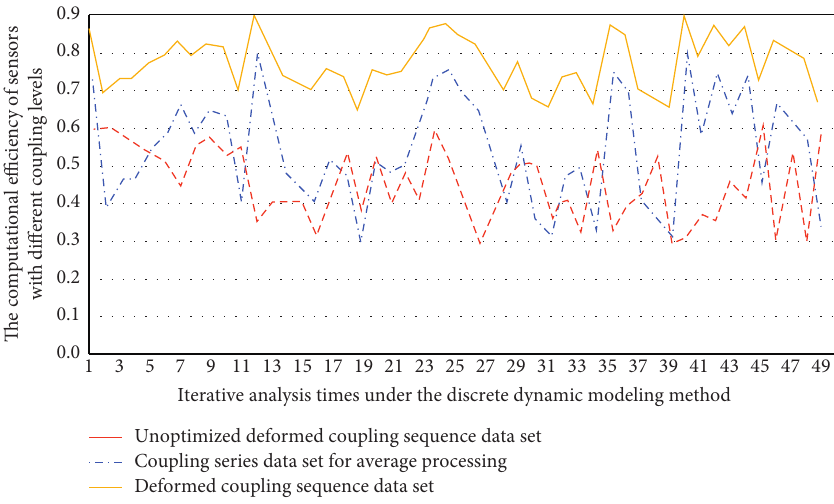
Figure 2: Simulation results of the relationship between the number of iterative analyses.